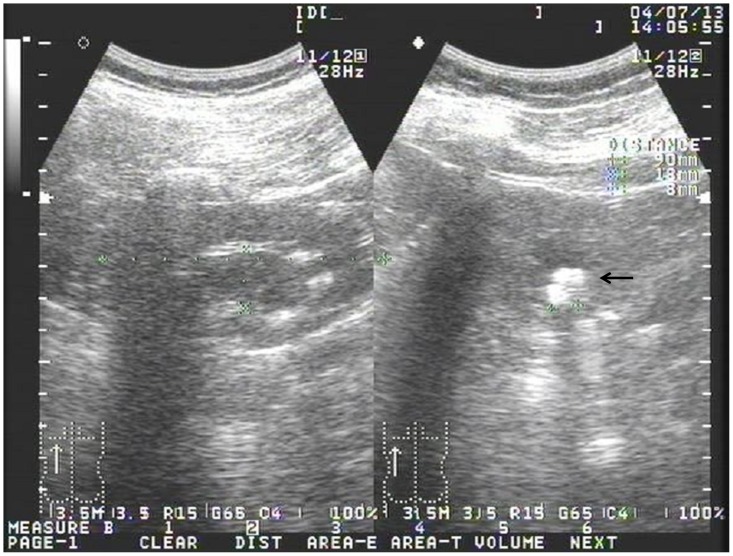
Sonography of the left kidney.A hyperechoic mass measuring 8(right panel, arrow).